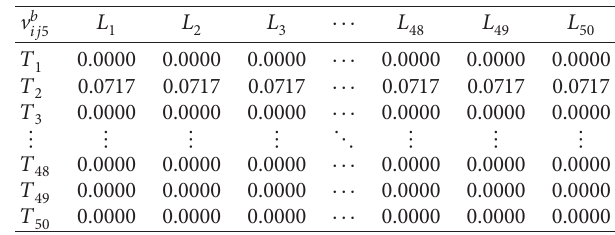
Table 28: Normative profit and loss matrix D tenants’ housing matching.